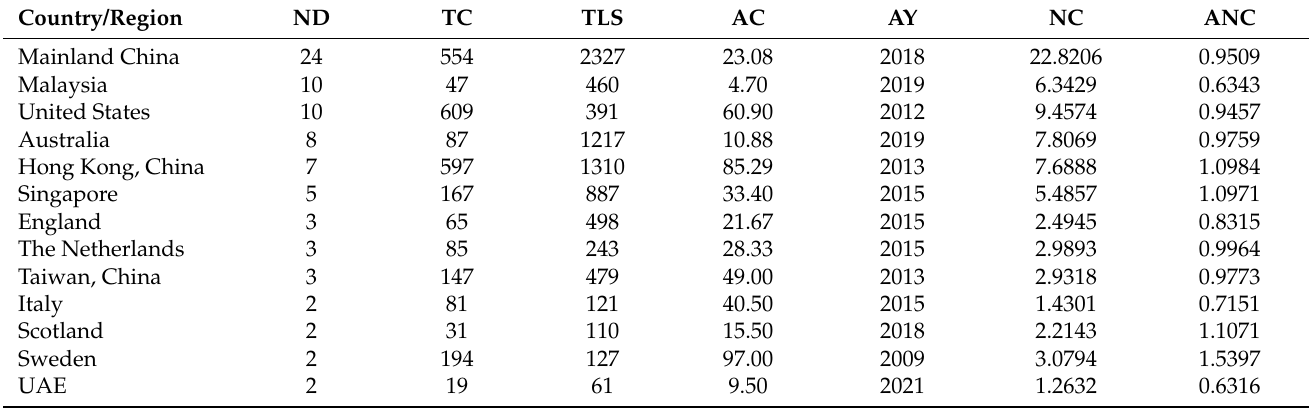
Figure 4. Researcher collaboration network map.